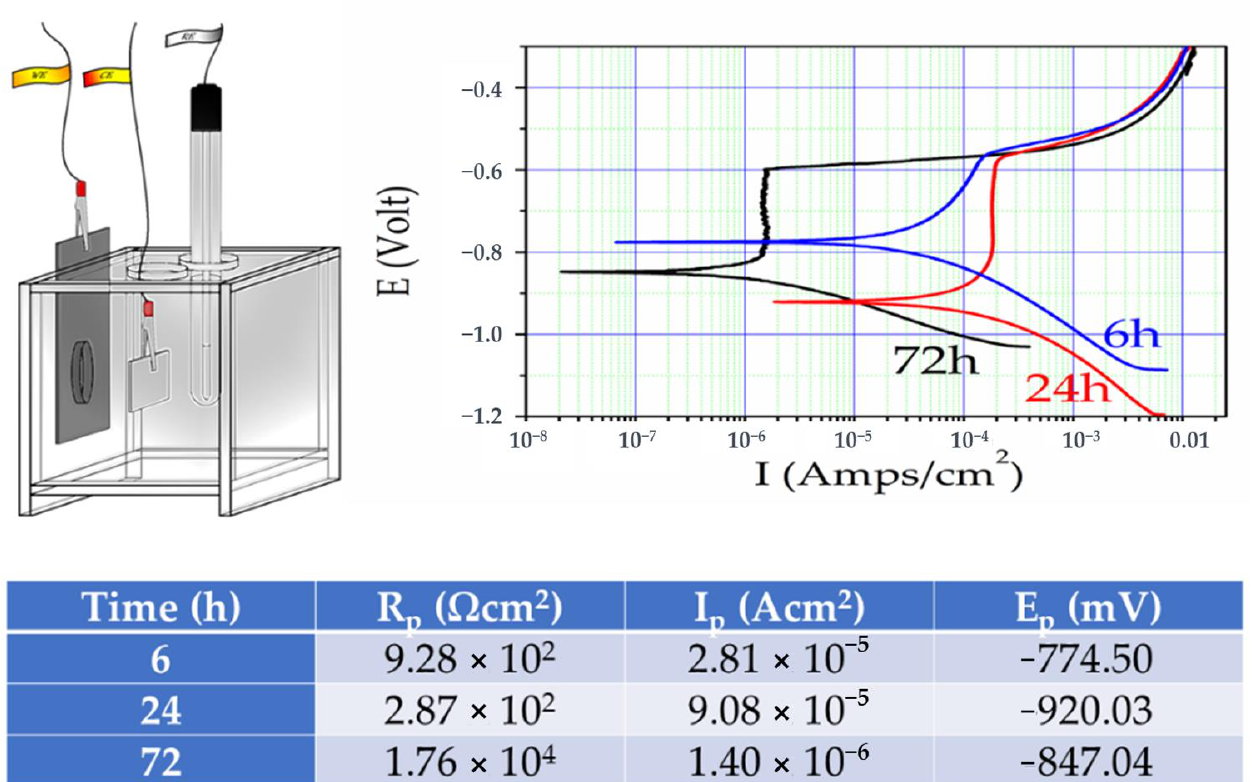
Figure 12. Polarization curves of the 8-HQ-loaded CeO 2 nanocontainers as a function of the time in a salt solution obtained in the Plexiglas setup and results of fitting the polarization curves: the R p , I o , and E o.